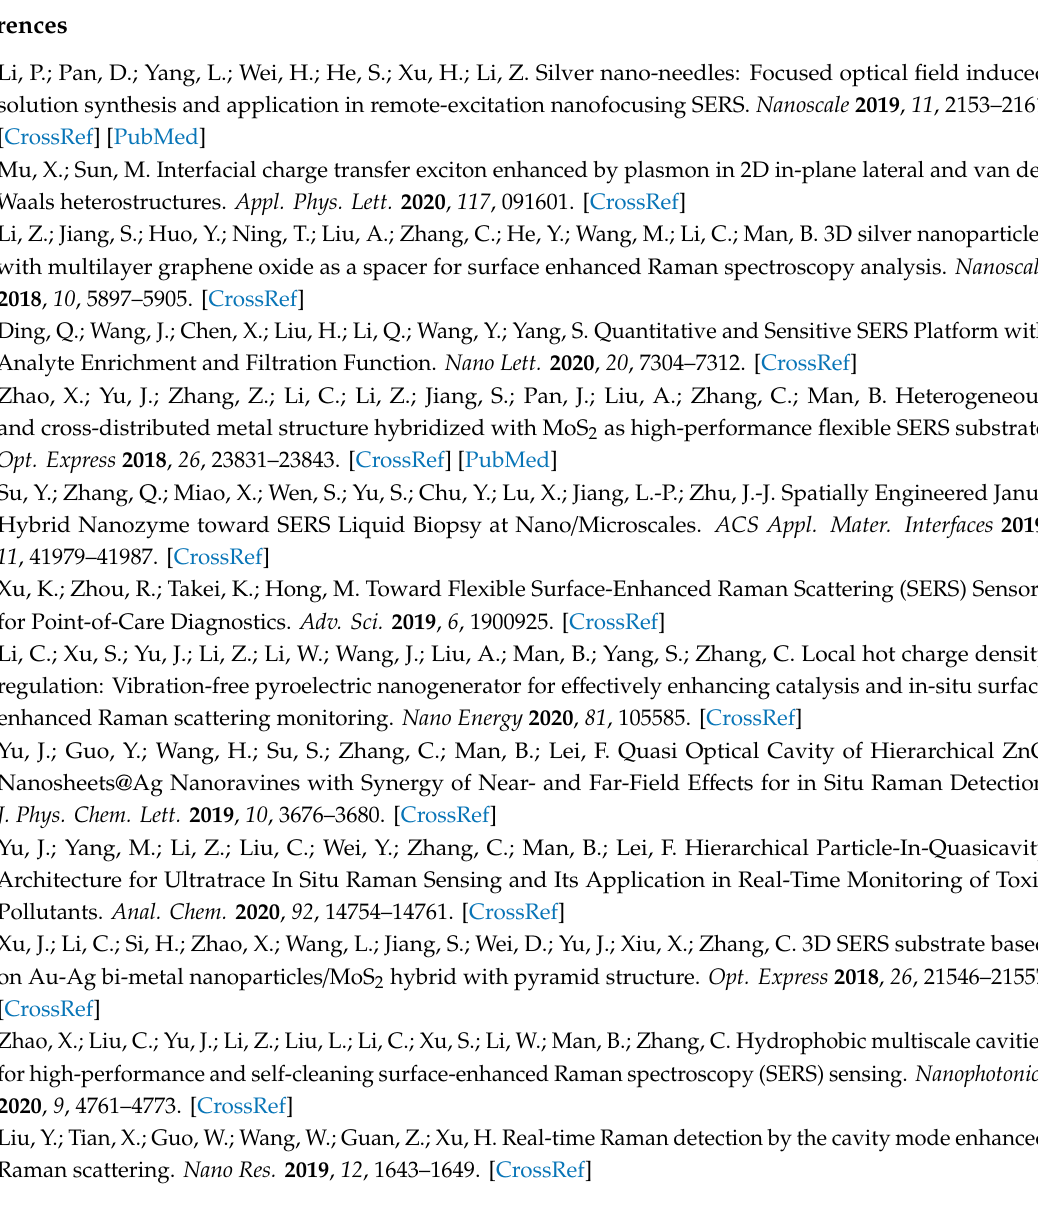
Figure S1: (a) The x-z views of electric field distribution of di ff erent number of CM–EM unit substrates at 532 nm wavelength. (b) Electric field enhancement (E / E 0 ) for substrate with di ff erent CM–EM units. Figure S2: The Raman signal intensity distribution of (a) R6G at 613 cm − 1 and (b) CV at 914 cm − 1 on multilayer substrate with four CM–EM units from 10 − 12 M to 10 − 14 M and from 10 − 10 M to 10 − 12 M, respectively. Figure S3: The x-z views of electric field distribution of substrate shifted